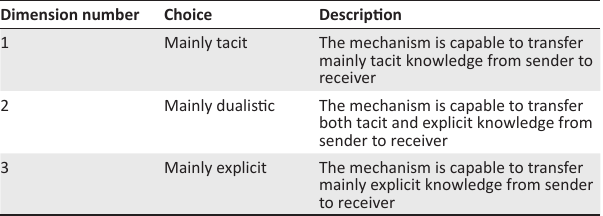
TABLE 2: Explicitness